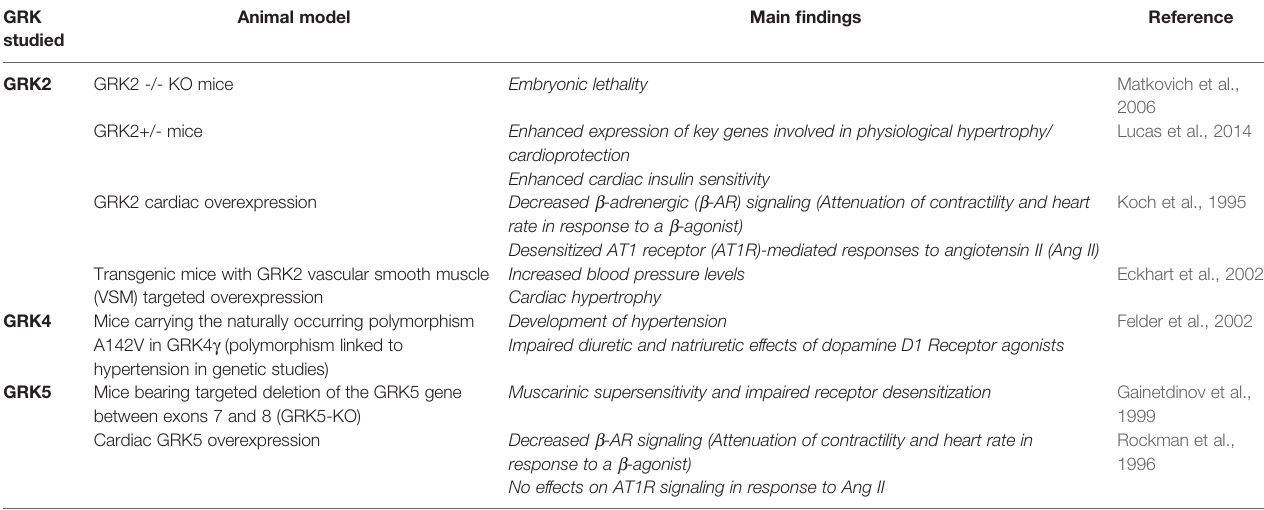
TABLE 2 | Animal models of GRKs genetic modi fi cations affecting cardiac